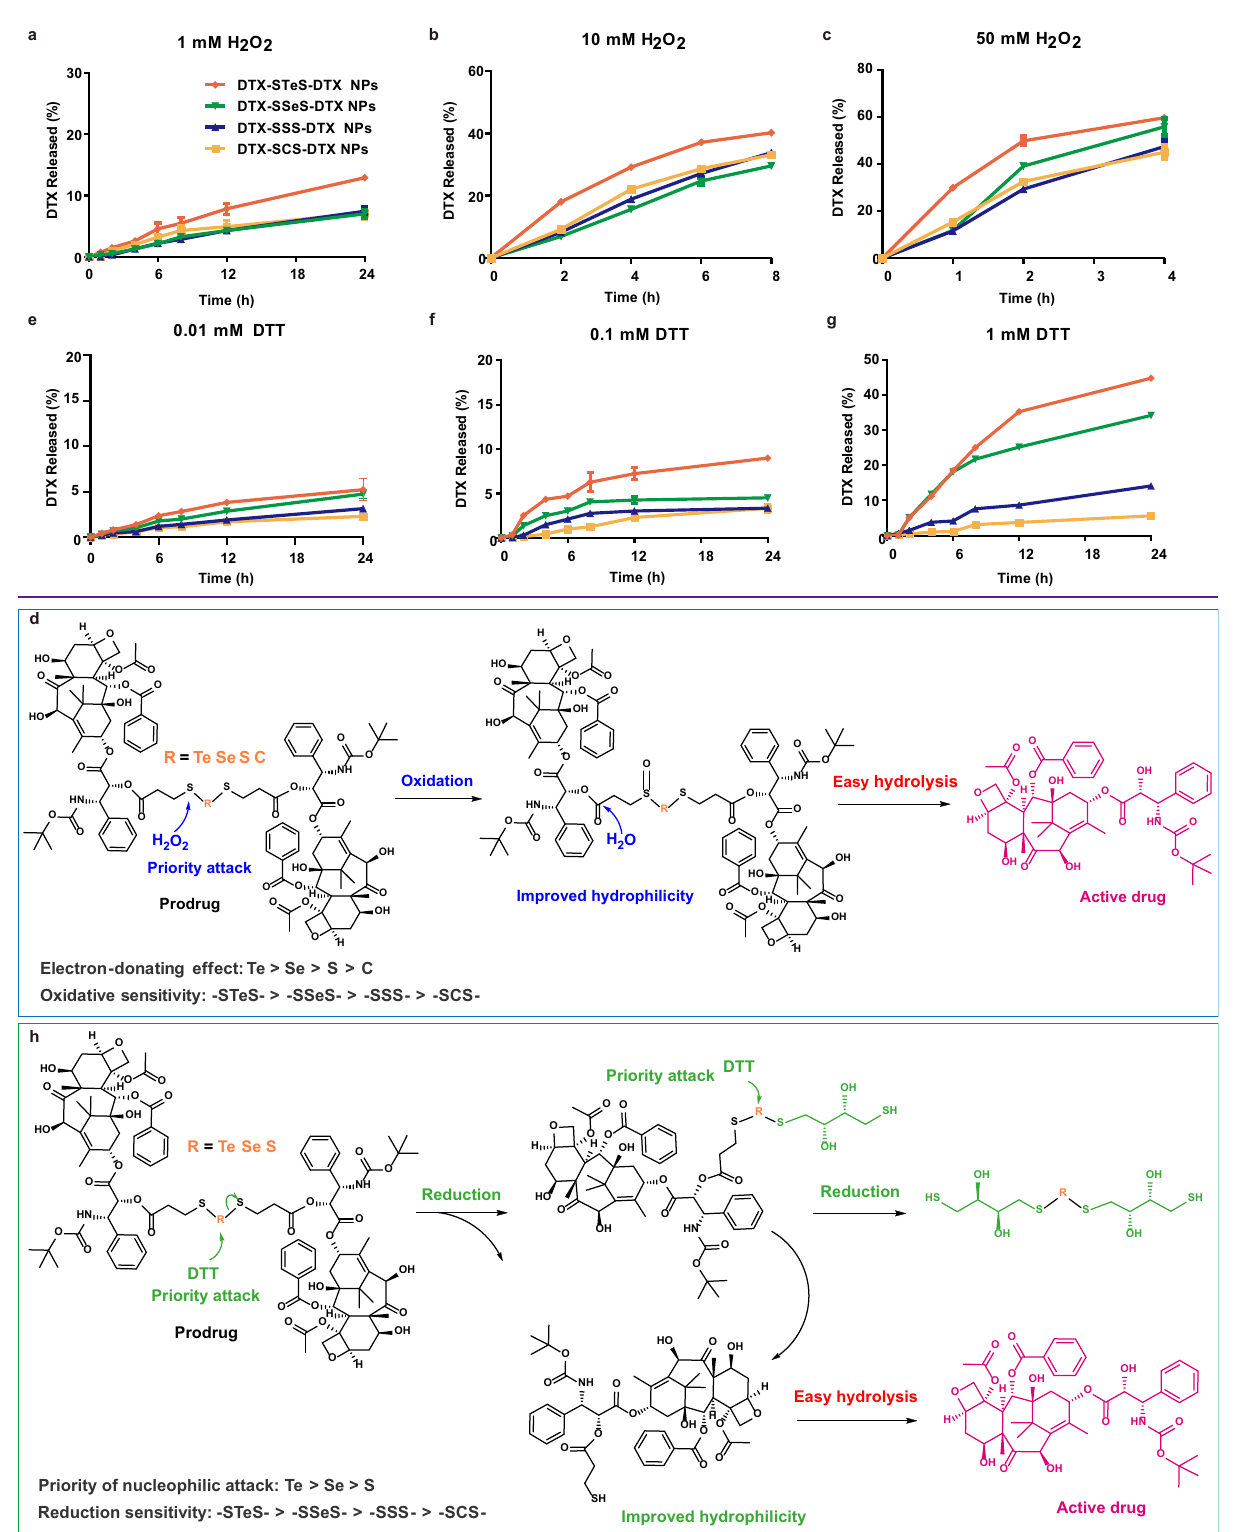
Fig. 4 | Redox dual-responsive bioactivation. a 1mM H 2 O 2 ; b 10mM H 2 O 2 ; c 50mM H 2 O 2 ; e 0.01mM DTT; f 0.1mM DTT; g 1mM DTT. All data of a – c , e – g were presented as the mean±SD ( n =3 independent experiments).